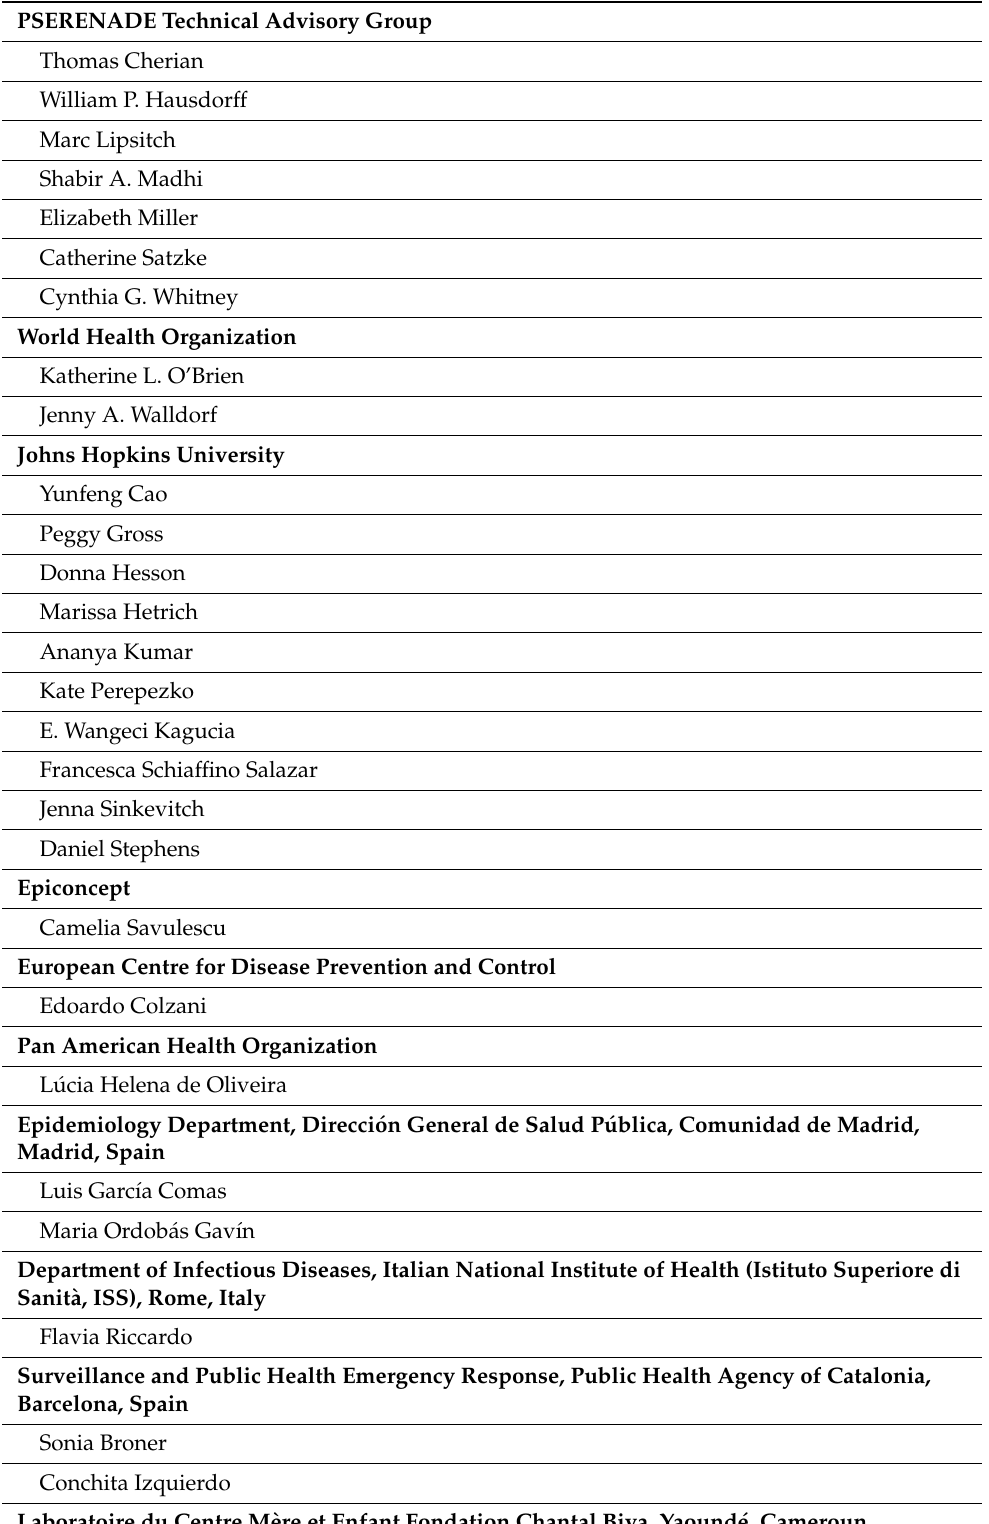
Table A2. Acknowledgement